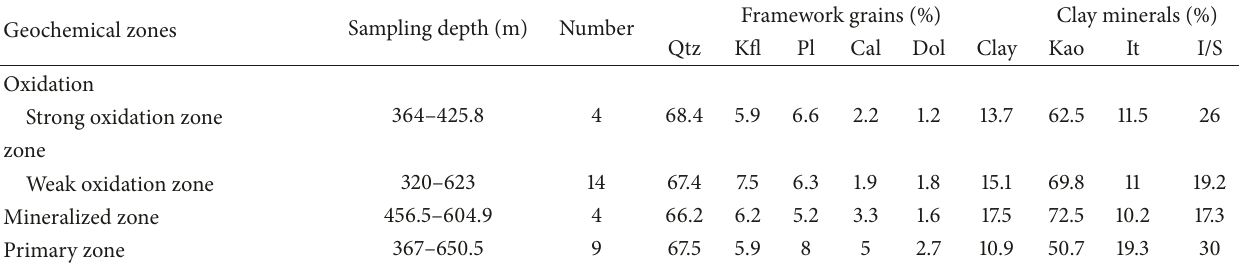
Table 2: Average percentage content of clay minerals in host rocks from each geochemical zone.